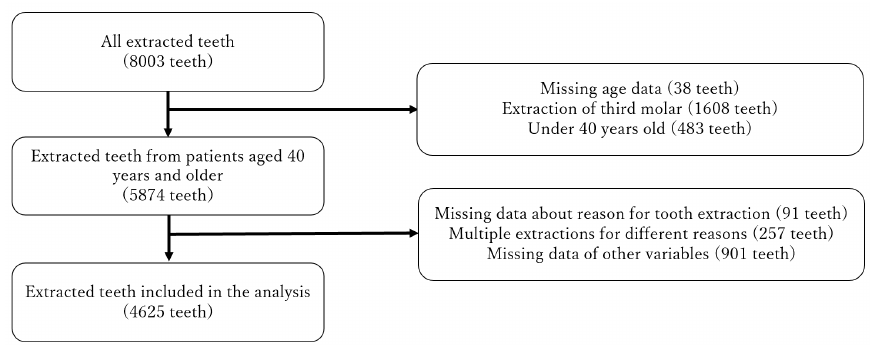
Figure 1. Flow chart summarizing the selection of the extracted teeth for the